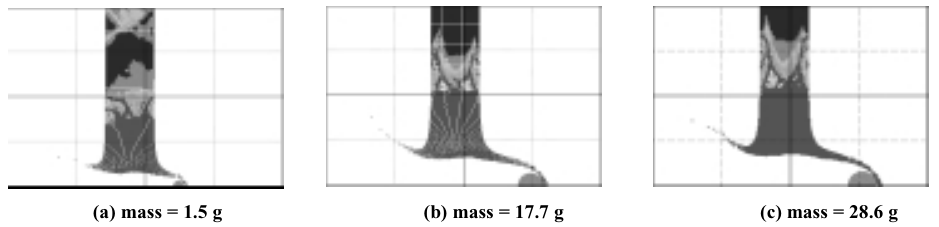
Fig. 7. Final damage states from fragment impacts at 1,370 m/s on 2000 psi targets.